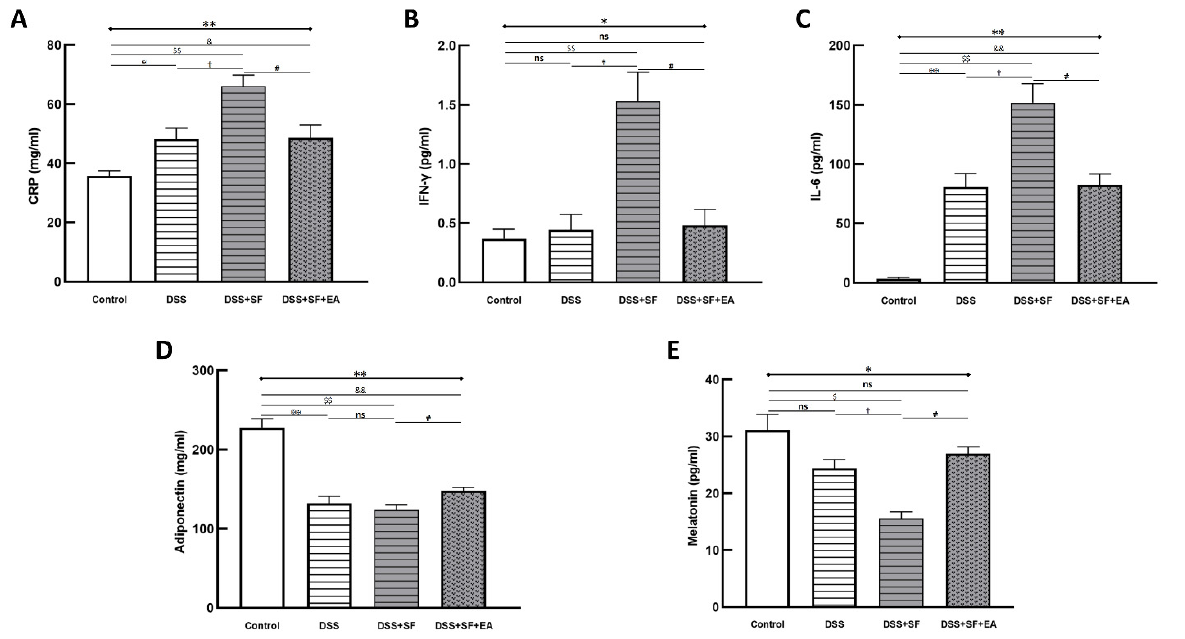
Figure 3. Electroacupuncture decreases plasma inflammatory marker/cytokines and increases adiponectin/melatonin in dextran sulfate sodium (DSS)-induced colitis with sleep fragmented C57BL/6 mice. ( A ) C-reactive protein (CRP), as an inflammatory biomarker, was elevated in DSS group and aggravated in DSS + SF group, then declined in DSS + SF + EA group. Similar trends were observed in other proinflammatory cytokines, including IFN- γ ( B ) and IL-6 ( C ). Adiponectin ( D ) and melatonin ( E ) level were decreased in DSS/DSS + SF groups and increased in DSS + SF + EA group. * Stands for a result of four groups comparison (represented by bold line segments with end- points). (cid:64) , (cid:63) , #, $ and & represent the results of control group versus DSS group, DSS group versus DSS + SF group, DSS + SF group versus DSS + SF + EA group, control group versus DSS + SF group, and control group versus DSS + SF + EA group, respectively (represented as a thin line without endpoints). *, (cid:64) , (cid:63) , #, $, &, p < 0.05; **, (cid:64)(cid:64) , $$, &&, p < 0.01; ns, no significance. Data were presented as mean ± SEM of five mice in each group. DSS, dextran sodium sulfate; SF, sleep fragmentation; EA,